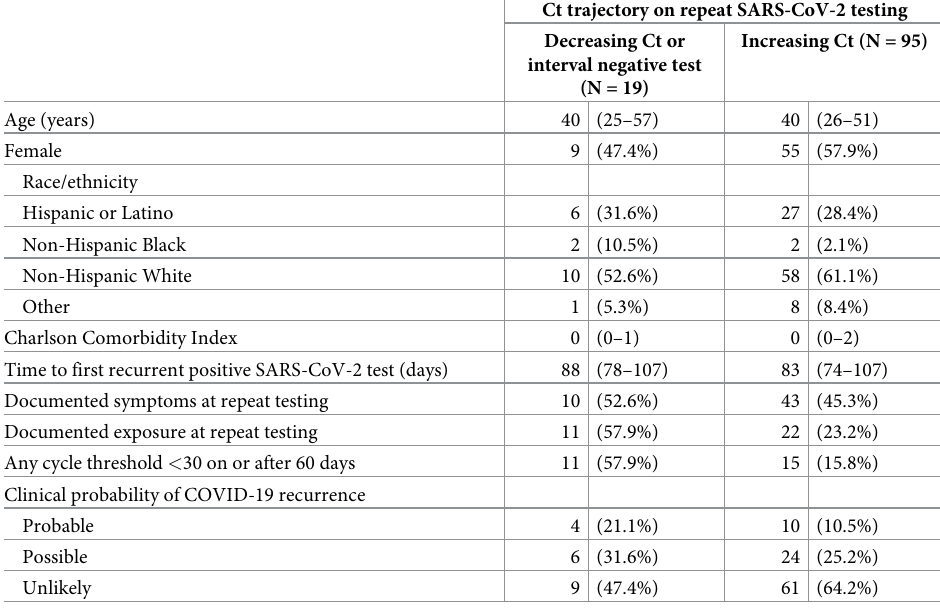
Table 4. Subject demographic characteristics by cycle threshold